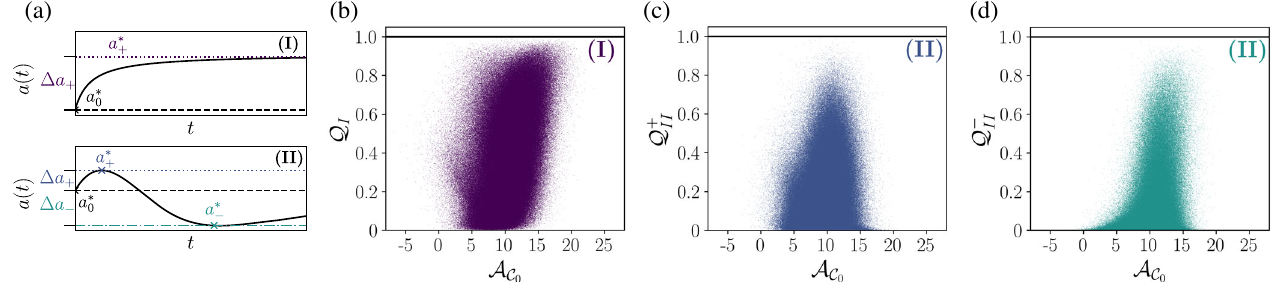
FIG. 3. Quality of the affinity bounds for the seven-state multicyclic network from Fig. 2. (a) Illustration of the quantities entering the definition of the quality factors for the two classes of network realizations. (I) shows a ð t Þ for a network realization belonging to class I. − a (cid:5) Since a (cid:5) 0 is the global minimum of a ð t Þ , the quality factor Q for this realization is defined according to Eq. (18) with Δ a ¼ j a (cid:5) 0 j I þ þ from Eq. (16). (II) shows a ð t Þ for a network realization belonging to class II. The quality factors Q þ and Q − for this realization are II II − a (cid:5) Δ a a (cid:5) − a (cid:5) – (d) defined according to Eqs. (20) and (21) with Δ a ¼ j a (cid:5) − − ¼ j 0 j and 0 j from Eqs. (16) and (17), respectively. (b) þ þ Quality factors Q , Q þ , and Q − for 2 063 495 randomly drawn rate configurations of the multicyclic network as a function of the affinity I II II A Q ≃ 0 . 4 , whereas the mean values of in (b) is given by Q C 0 of the smallest contributing cycle. The mean value of the quality factors I I ≃ 0 . 2 and Q − ≃ 0 . 1 , respectively. The difference between the quality factors the quality factors Q þ in (c) and Q − in (d) are given by Q þ II II II II in (c) and (d) for the same class of network realizations is caused by the ensemble for the transition rates that is biased towards positive affinities, explained in detail in Appendix E. All quality factors are determined from the corresponding waiting time distributions derived with the method explained in Appendix A